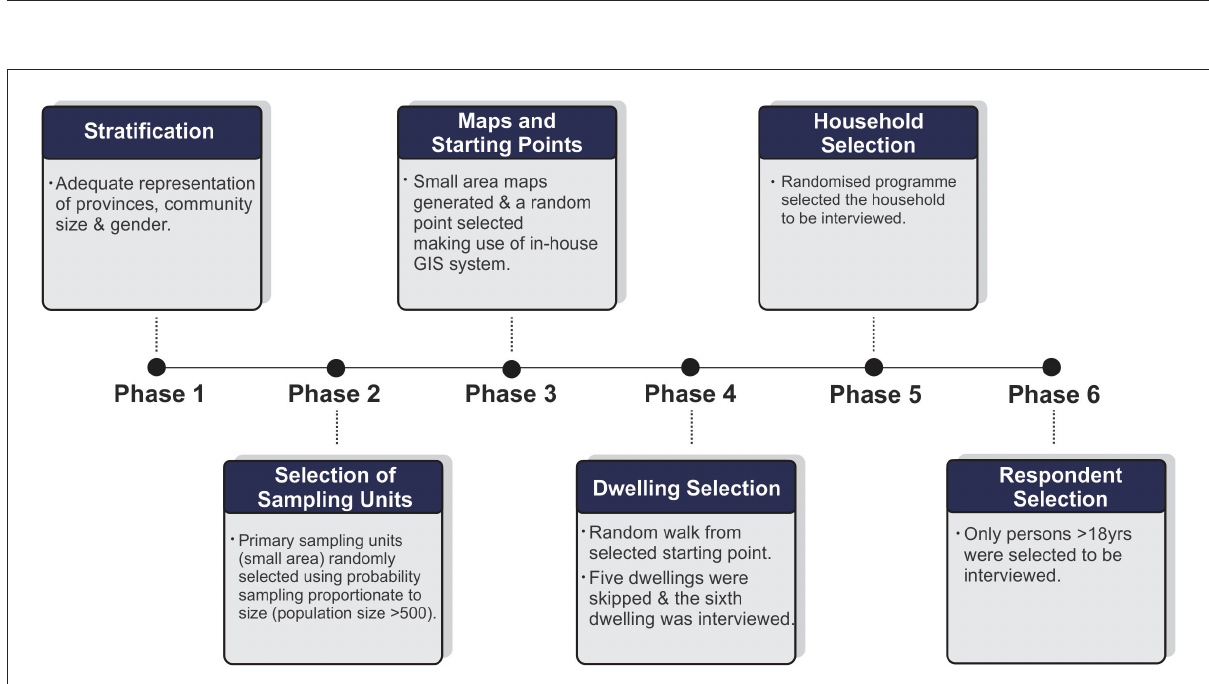
FIGURE2 Schematic illustration of the six phases of data collection. GIS, Geographical Information